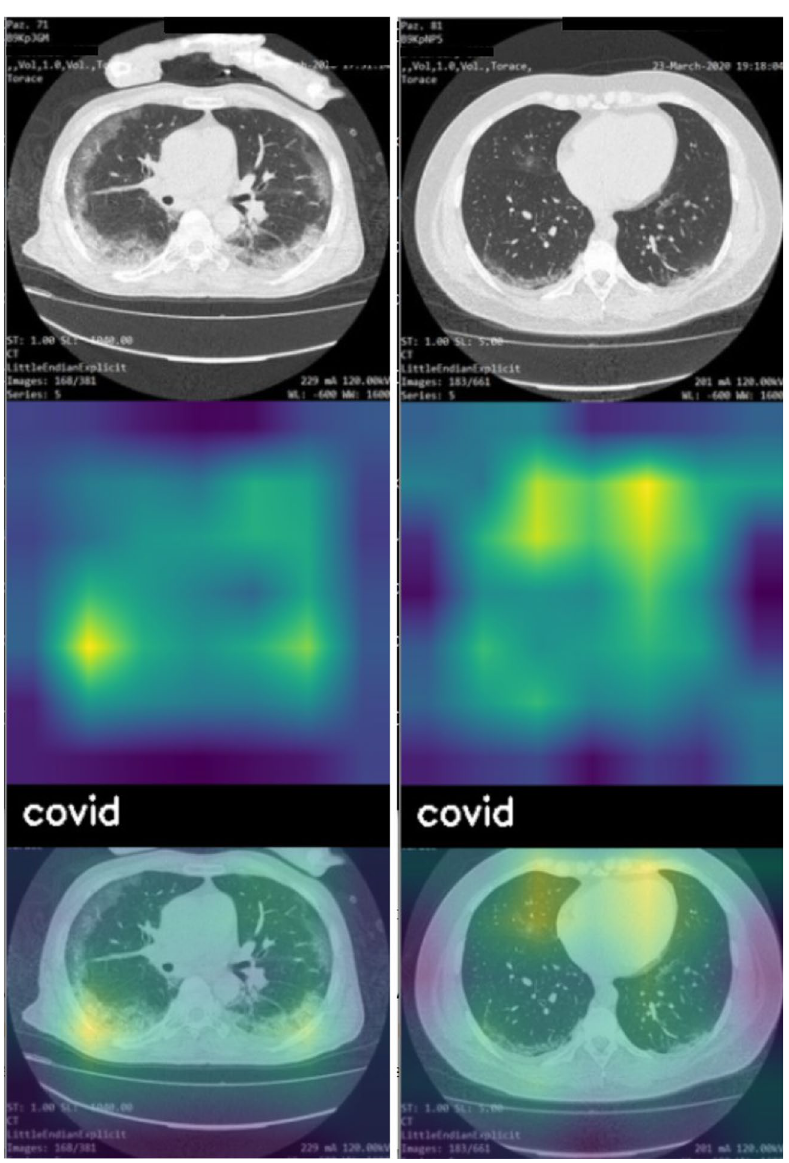
Figure 3. Two slices belonging to two different covid-19 patients with the related activation maps: in yellow the areas symptomatic of the covid-19